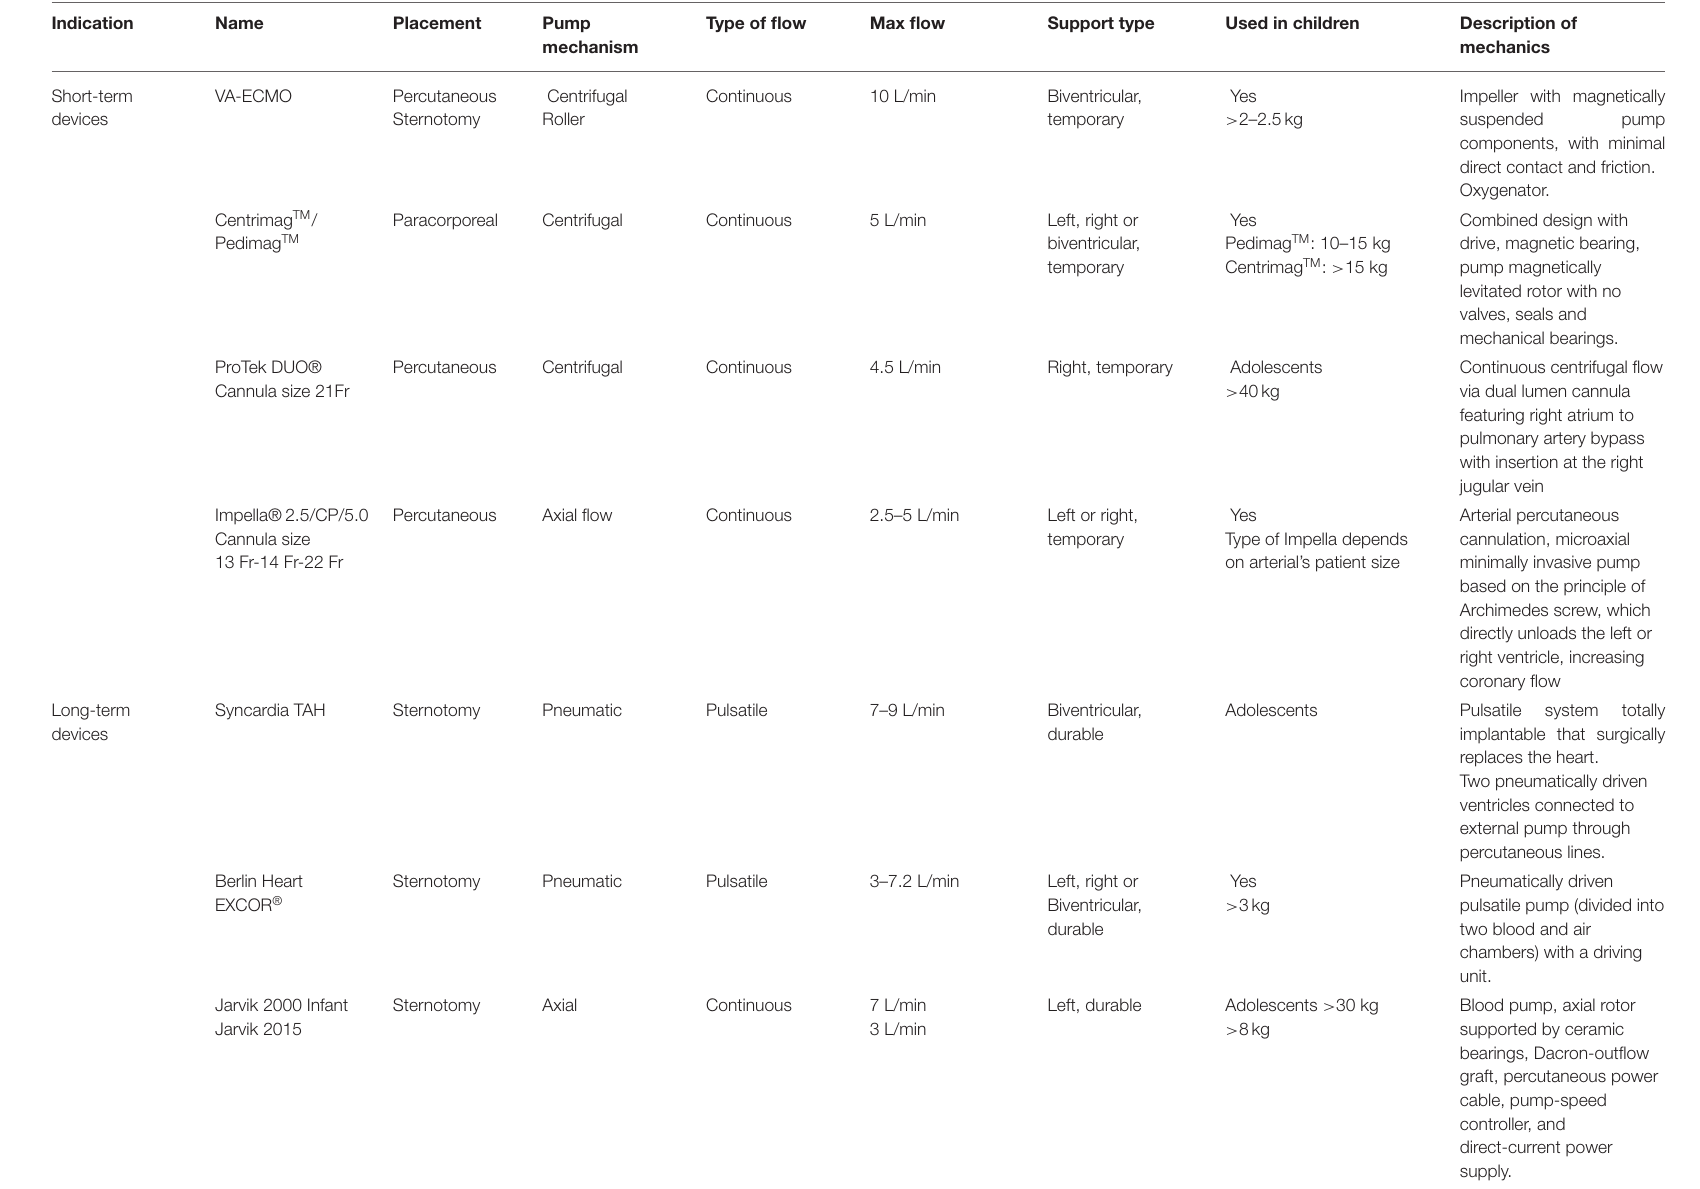
TABLE 1 | Main characteristics of available MCS